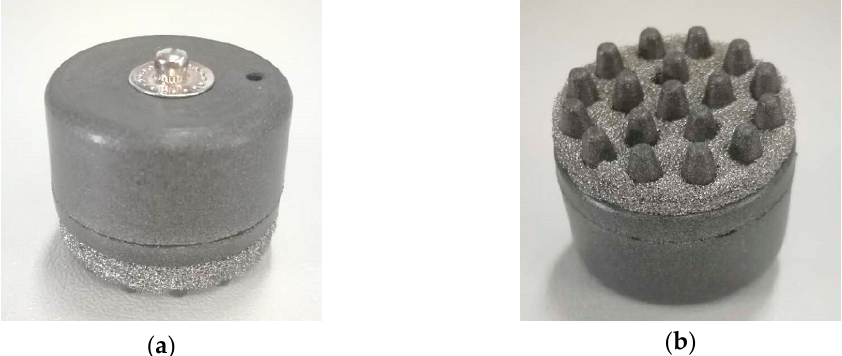
Figure 3. Schematic diagram of the electrode body layer.